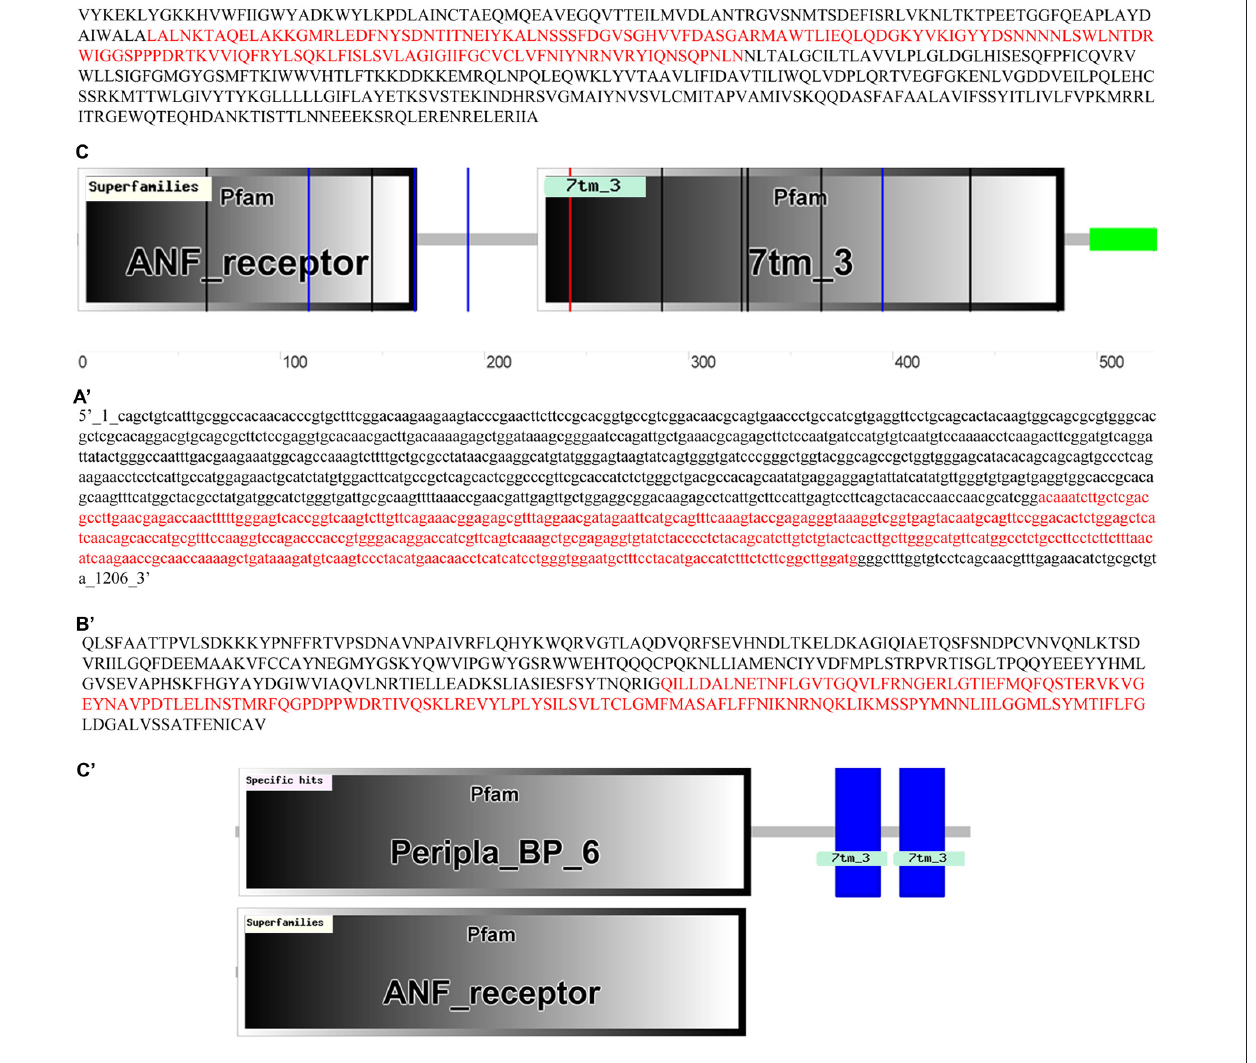
brightness and contrast with Adobe Photoshop CS4 to compose the plates. No staining was observed when sense probes were